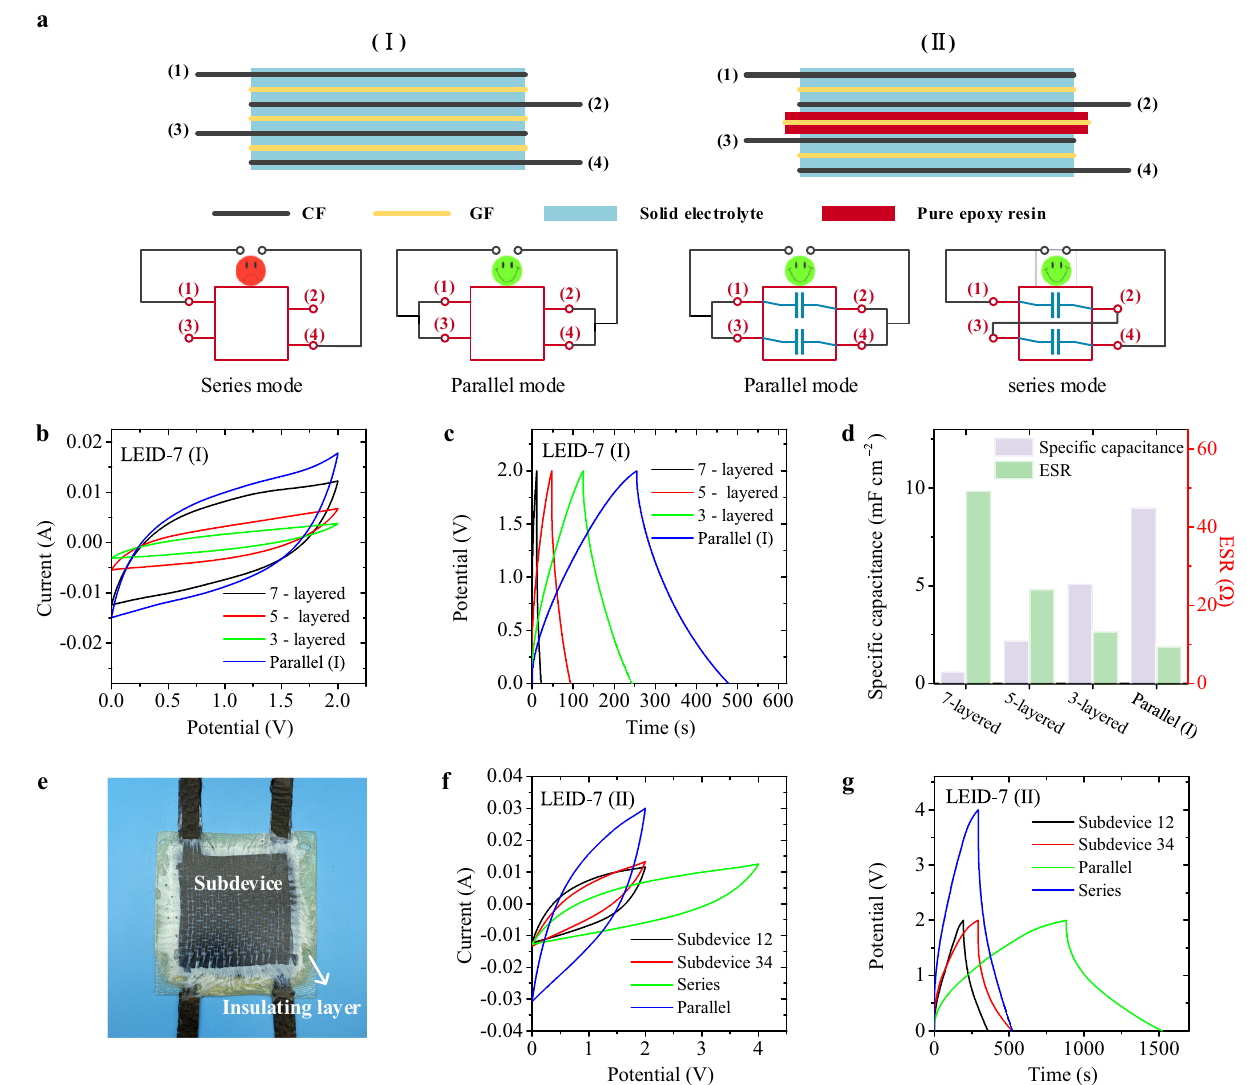
fi ve-, and seven- layered subdevices of LEID-7(I) and parallelly connected LEID-7(I). Current density: 0.08mAcm − 2 . e Photo of a LEID-7(II). f , g CV curves ( f ) and GCD curves ( g ) of LEID-7(II) as a whole in series and parallel modes and the two sub- devices of